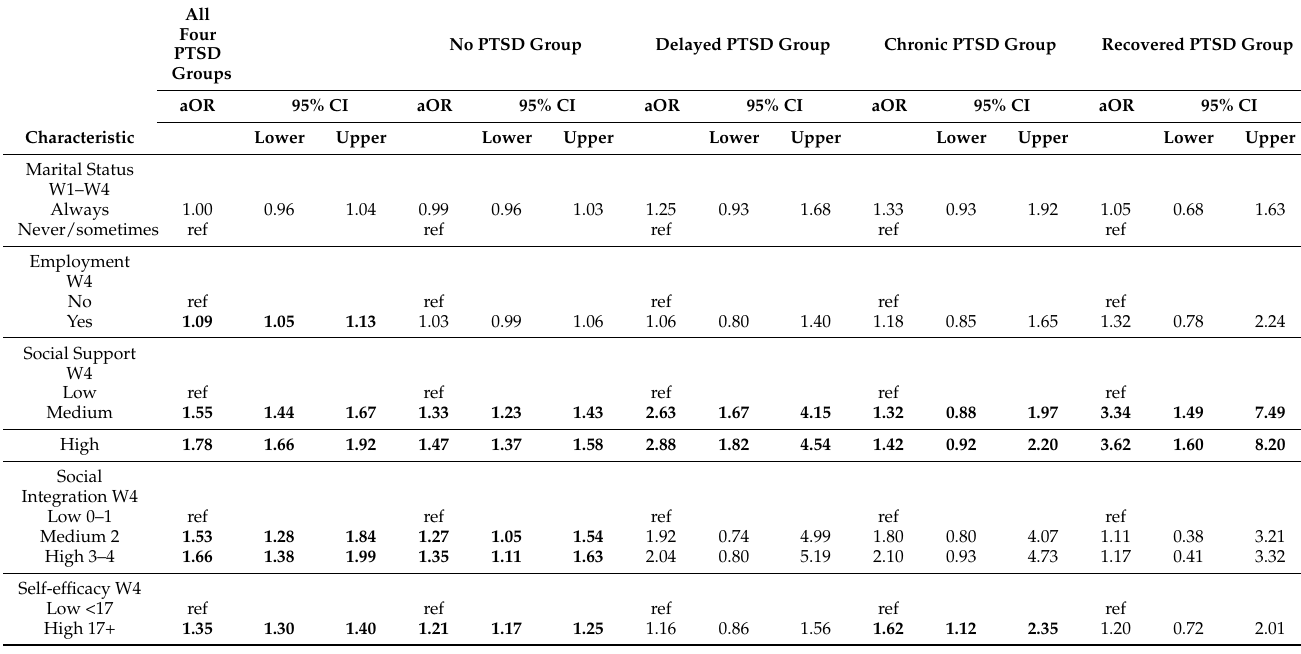
Table 4. Multivariable logistic regression results of the psycho-social factors with emotional embeddedness, stratified by PTSD